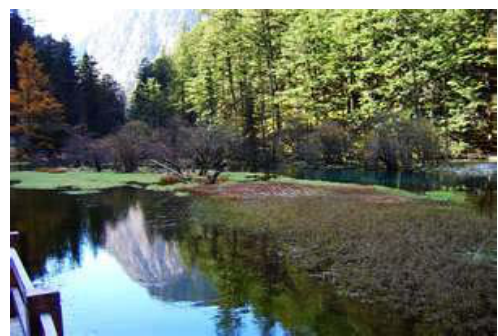
Figure 23. Original scenery picture.